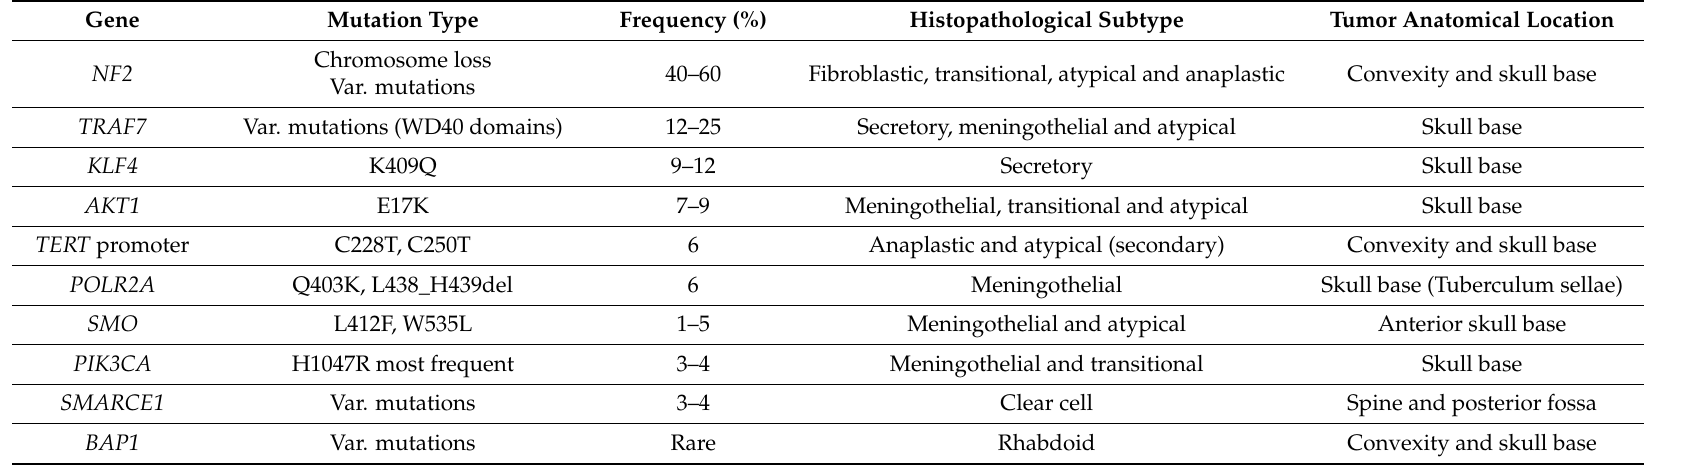
Table 1. Genetic alterations in